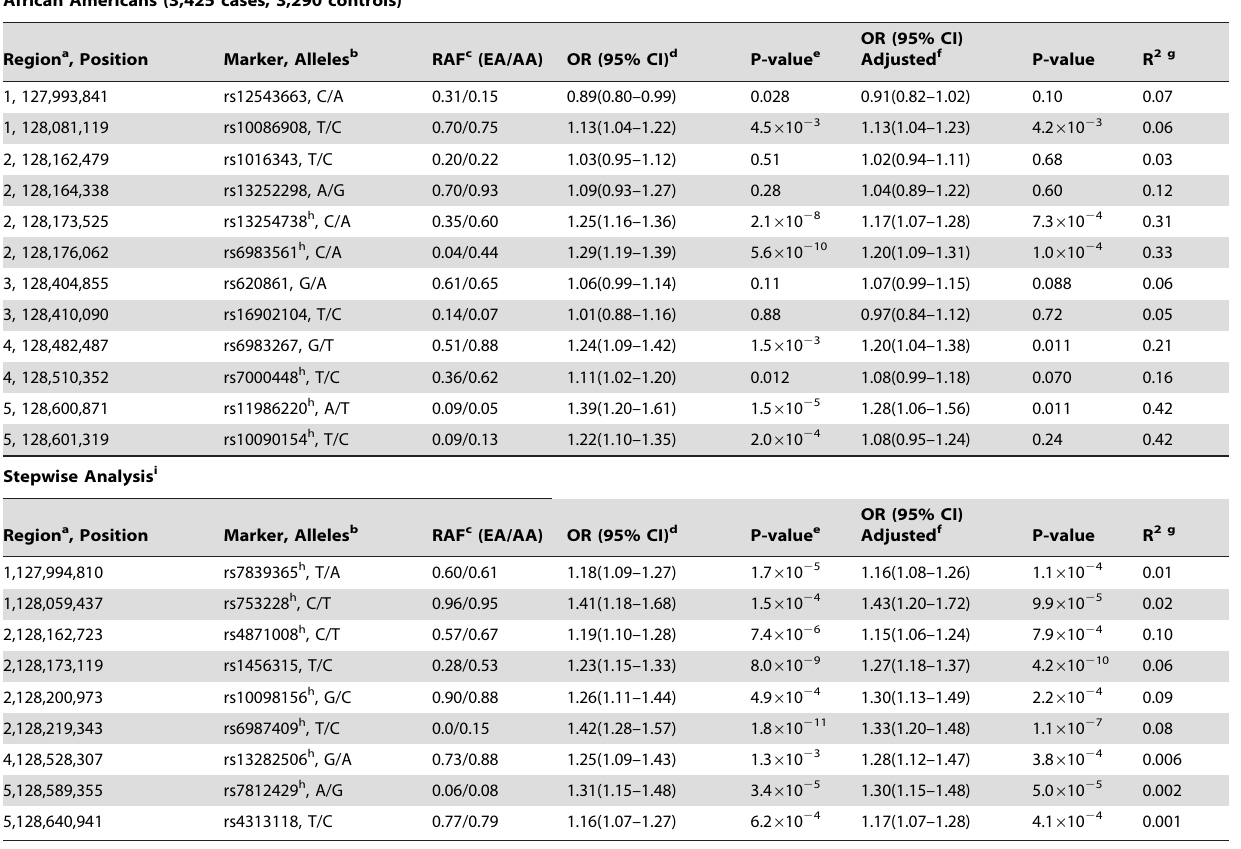
African Americans (3,425 cases, 3,290 controls)